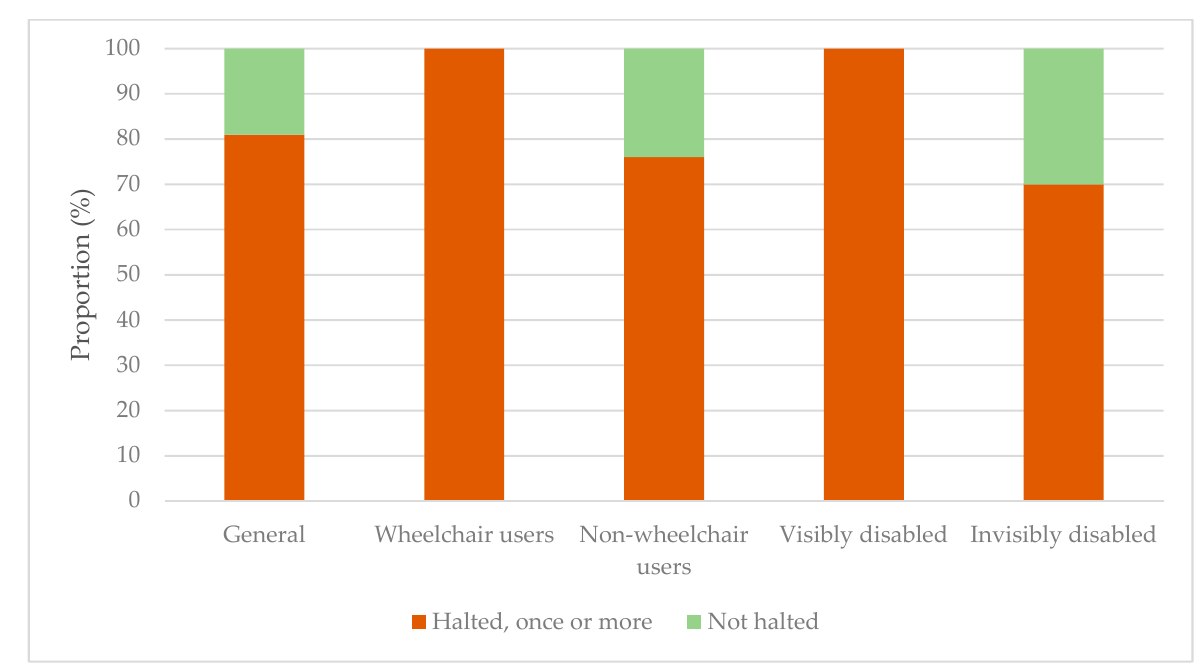
Figure 5. Proportions of participants halted once or more with their current assistance dog at public places: in general and differentiated into subgroups.